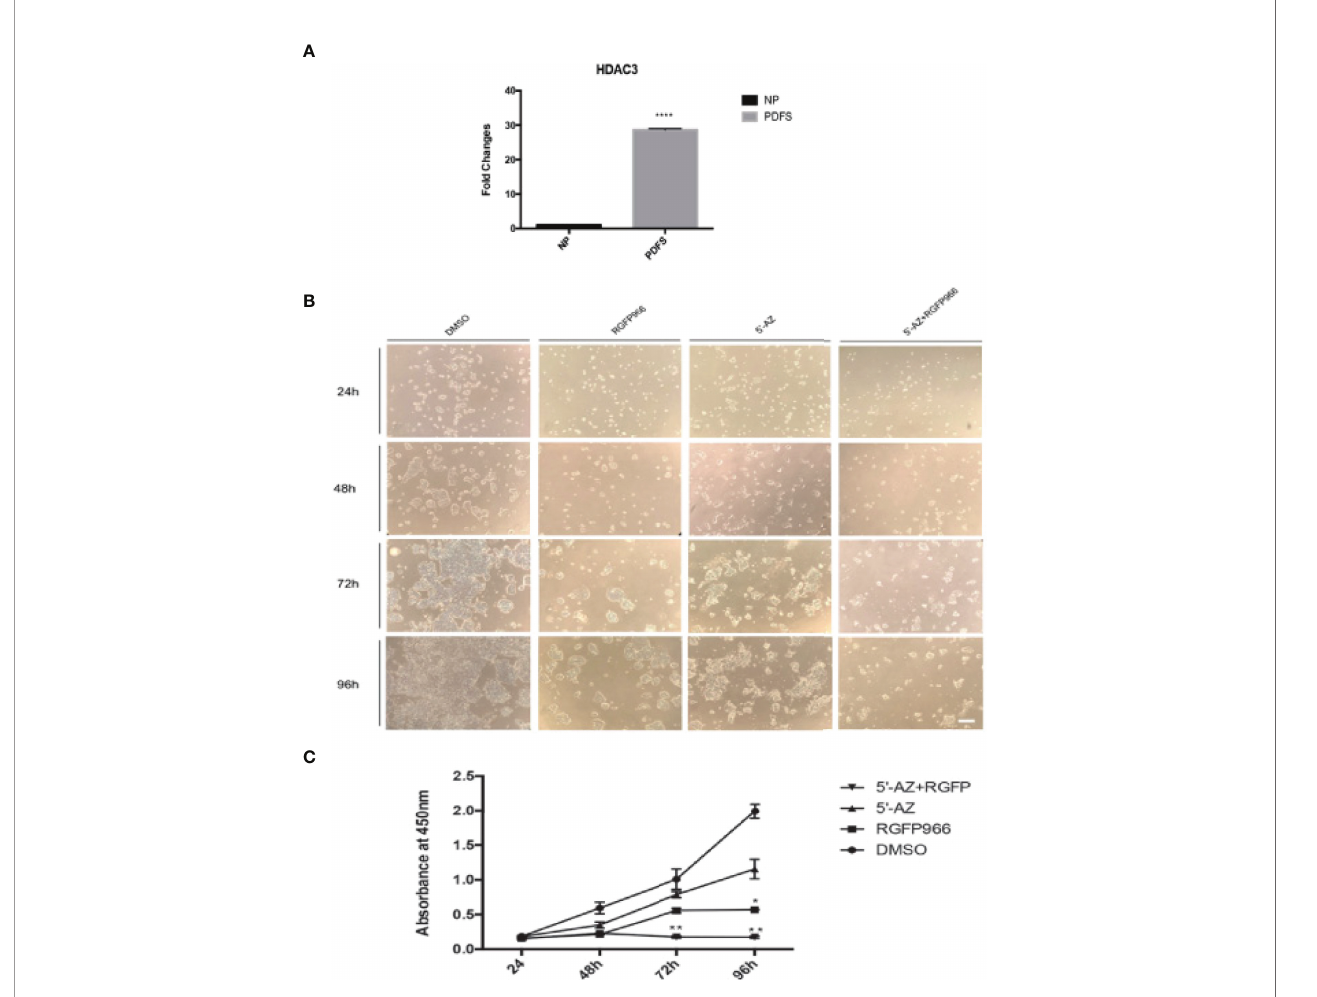
FIGURE 4 | HDAC3 inhibition and DNA demethylation decreases PDFS cell proliferation. (A) HDAC3 expression in PDFS cells and normal pituitary. ****p < 0.00001. (B) PDFS treated with HDAC3 inhibitor RGFP966 (10 m M) and DNMT inhibitor 5 ’ -AZA (1 m M), alone and in combination, at 24, 48, 72, and 96 hours. DMSO was added as a control. (C) Growth curves of PDFS cells as determined by CCK8 Assays. *P < 0.01; **P < 0.001; ****P < 0.00001. Scale Bar = 100 m m.